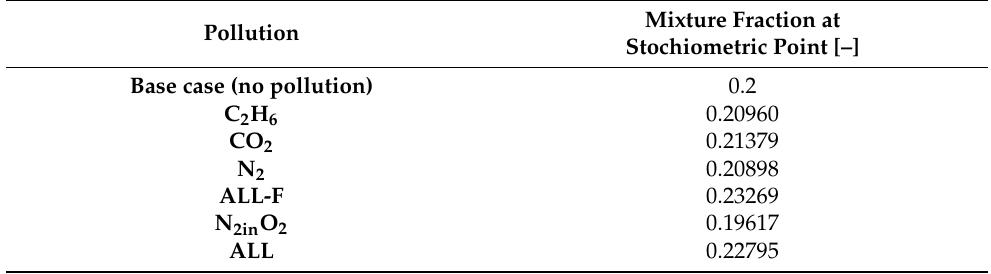
Table 5. Mixture fraction at stochiometric point for the different pollution cases.